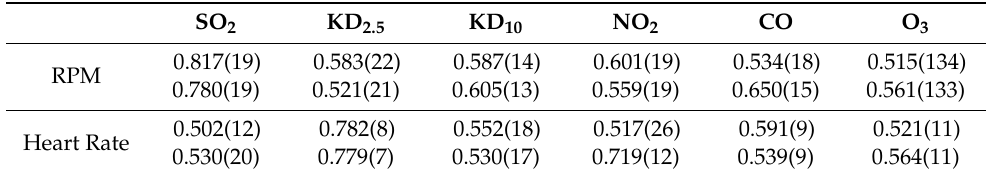
Table 5. The e ff ect of built environment pollution on physiological states such as the heart rate and breathing rate. SO